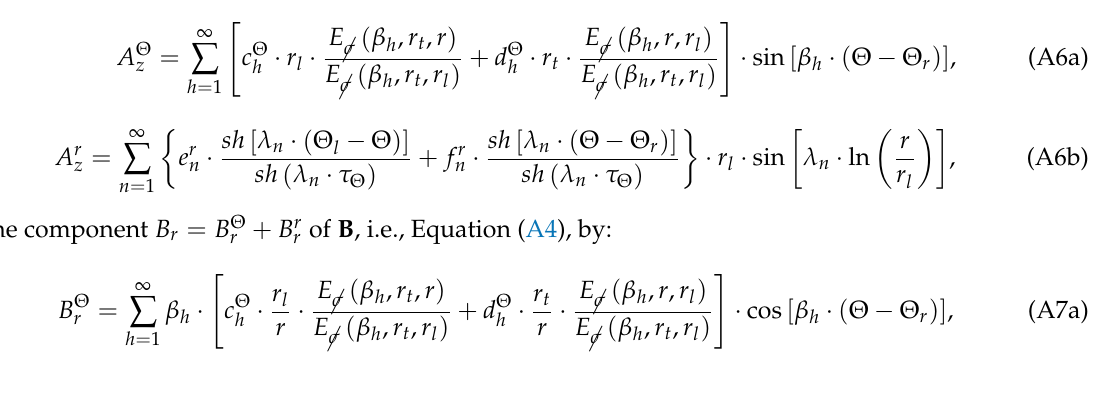
Θ + A r , i.e., Equation (A2), is redefined z z